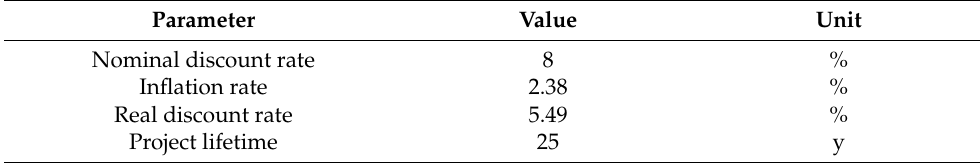
Table 4. Financial parameters.